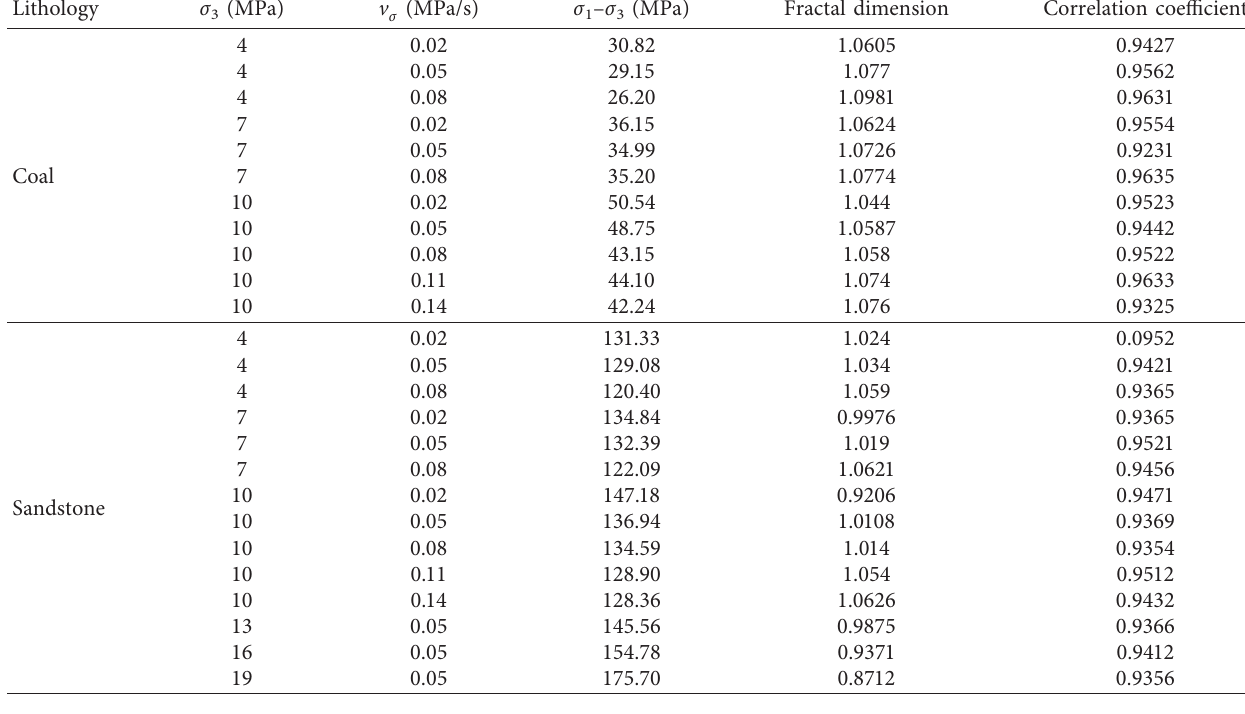
Table 4: Fractal dimensions of surface cracks with different unloading conditions.